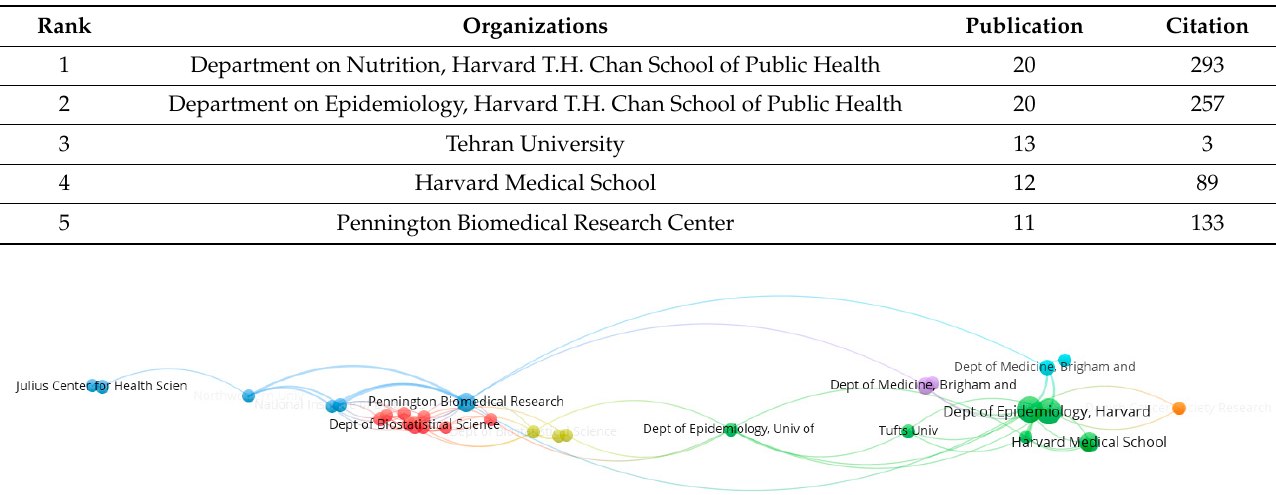
Table 3. Top five organizations publishing lifestyle research, 2016–2020.